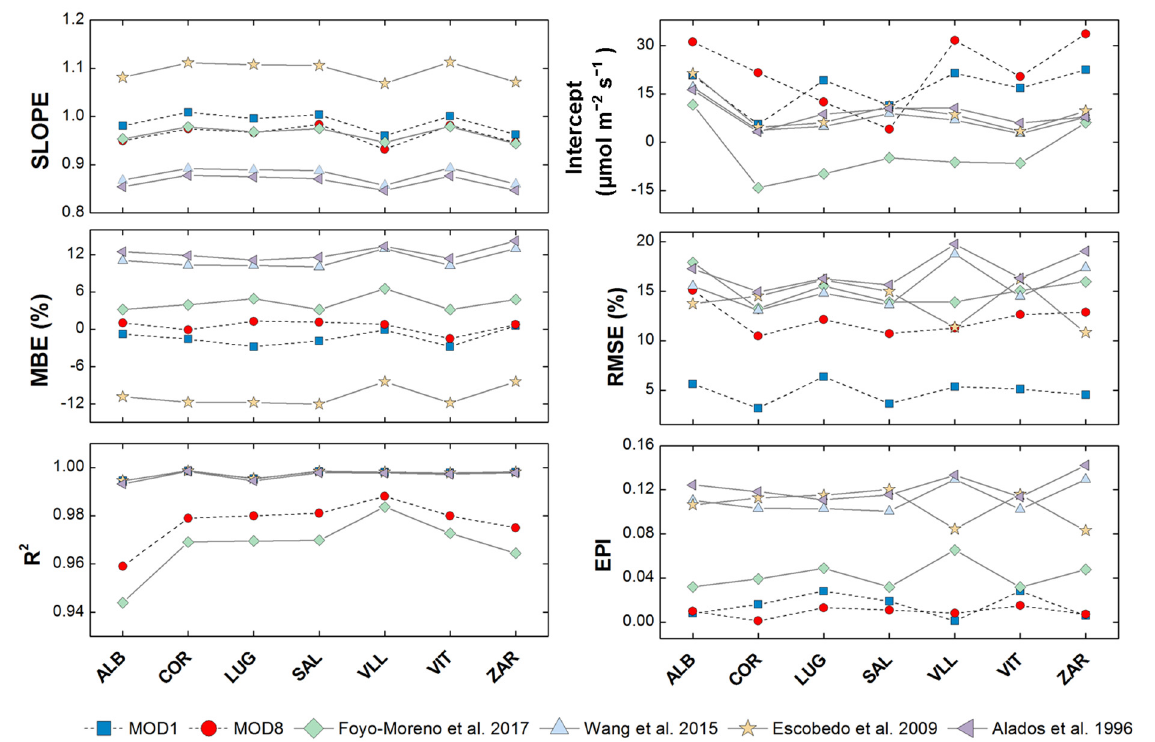
Figure 6. Comparison between Models 1 and 8 against bibliography